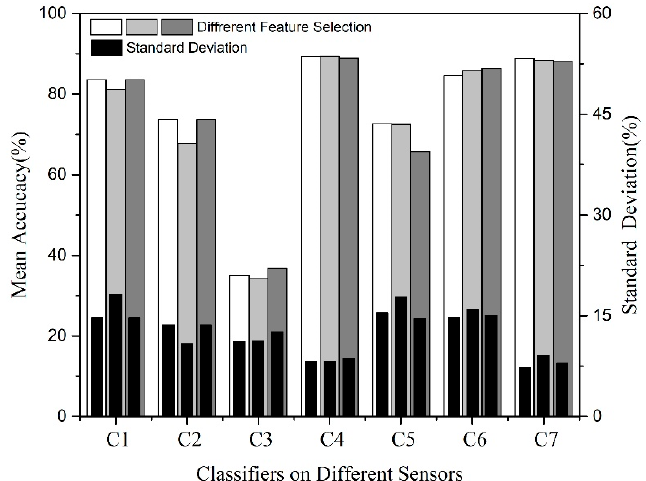
Figure 5. Classification results with different sensor datasets and feature selections.